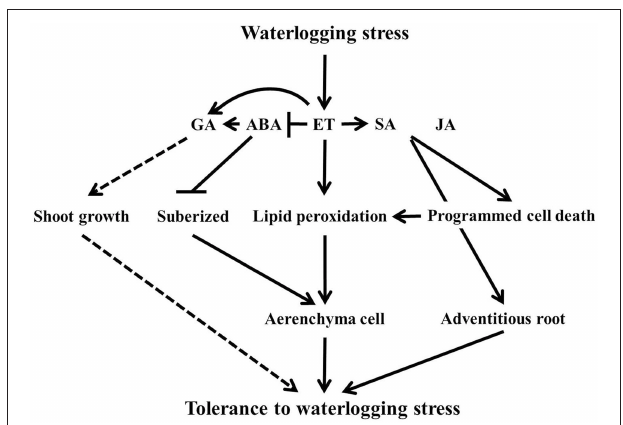
FIGURE 8 | The scheme of the waterlogging tolerance mechanism under plant hormones level. In the figure, solid lines indicate induction or increase and dashed line arrows indicate putative response. The line with bars shows suppressed or